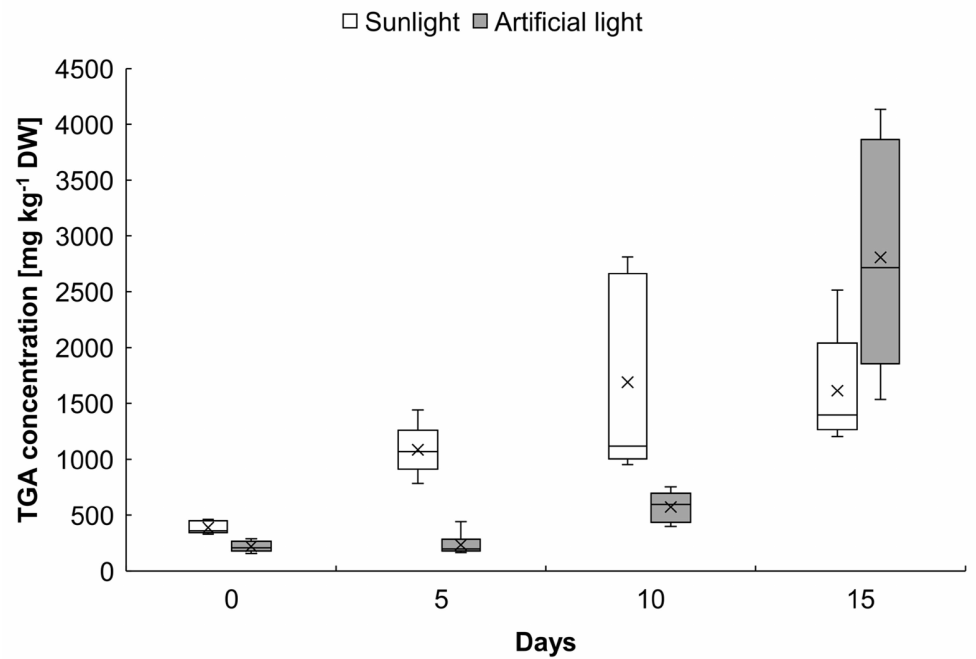
Figure 6. Total glycoalkaloid (TGA) concentration in tubers of cv. Agria in day 0 (ungreened tubers) and 5, 10, and 15 days after exposure to sunlight and artificial light. x represents the mean, error bars indicate the minimum and maximum values; the band inside the box represents median from six